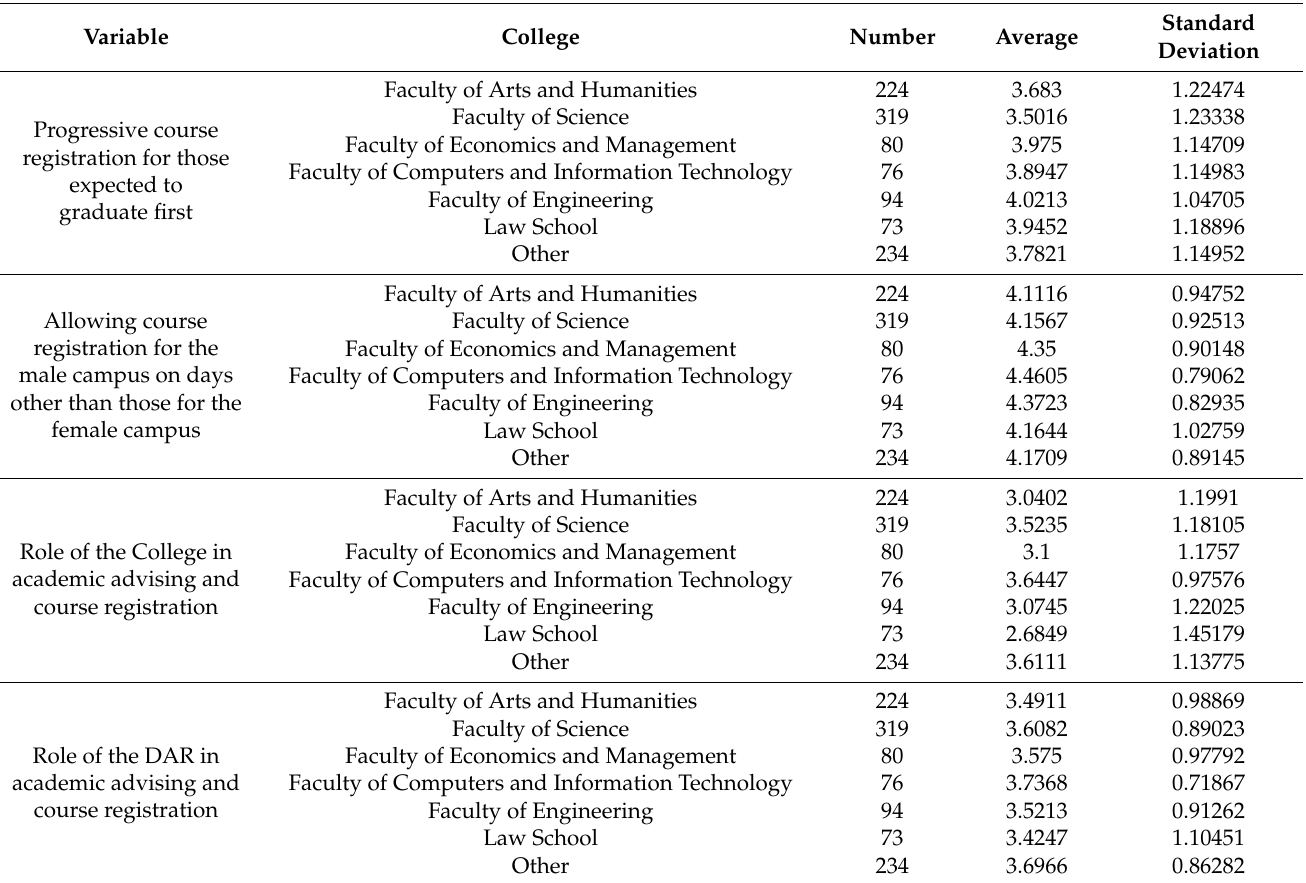
Table 20. Descriptive statistics of study variables by